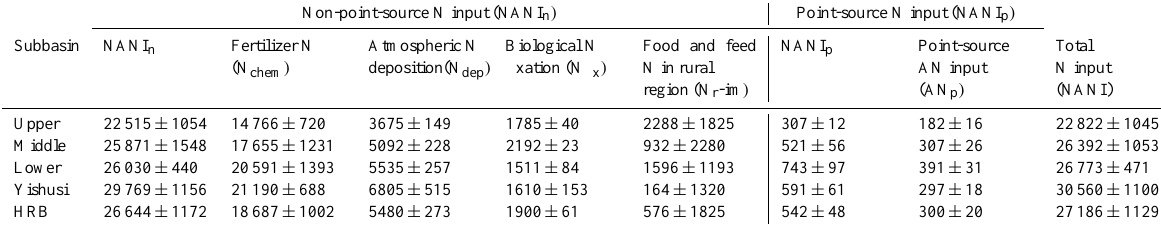
Table 3. Average N inputs to Huai River basin during 2003–2010 (mean ± SD,kgNkm − 2 yr − 1 )